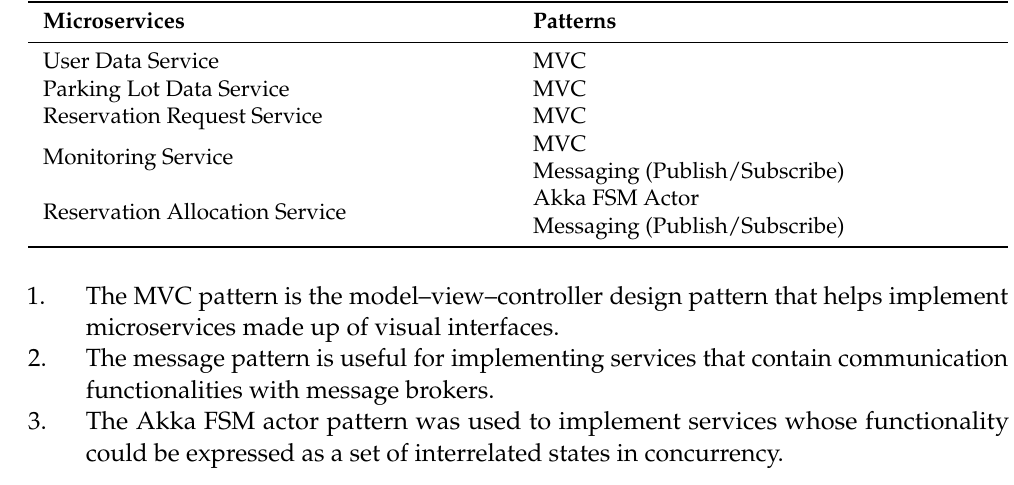
Table 2. Microservices and used